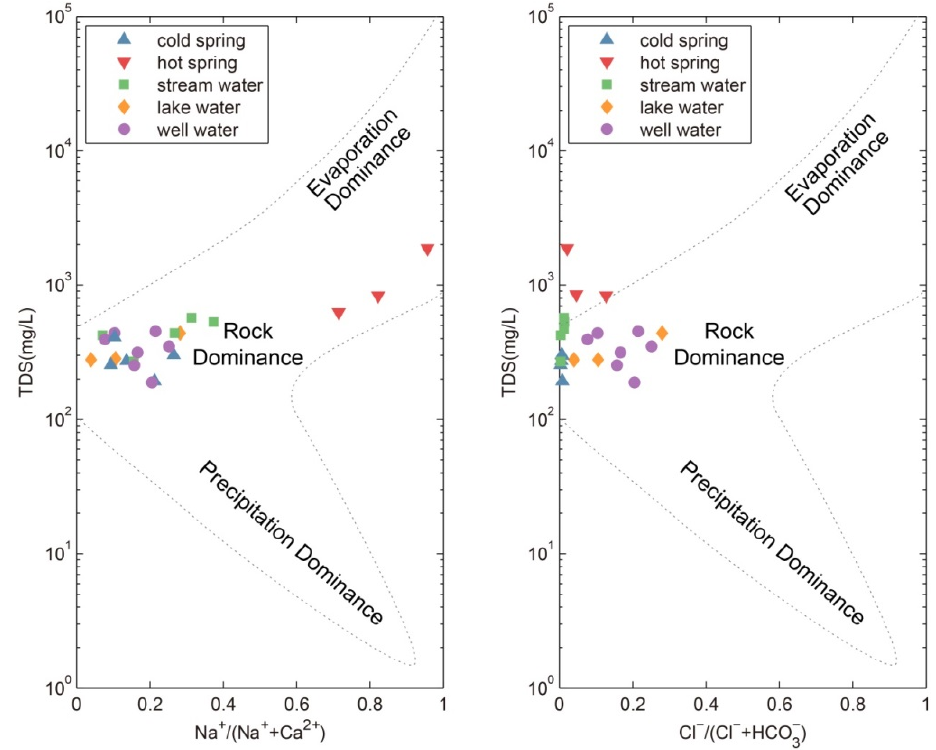
Figure 5. Gibbs diagrams for the major ion compositions of the 23 water samples.